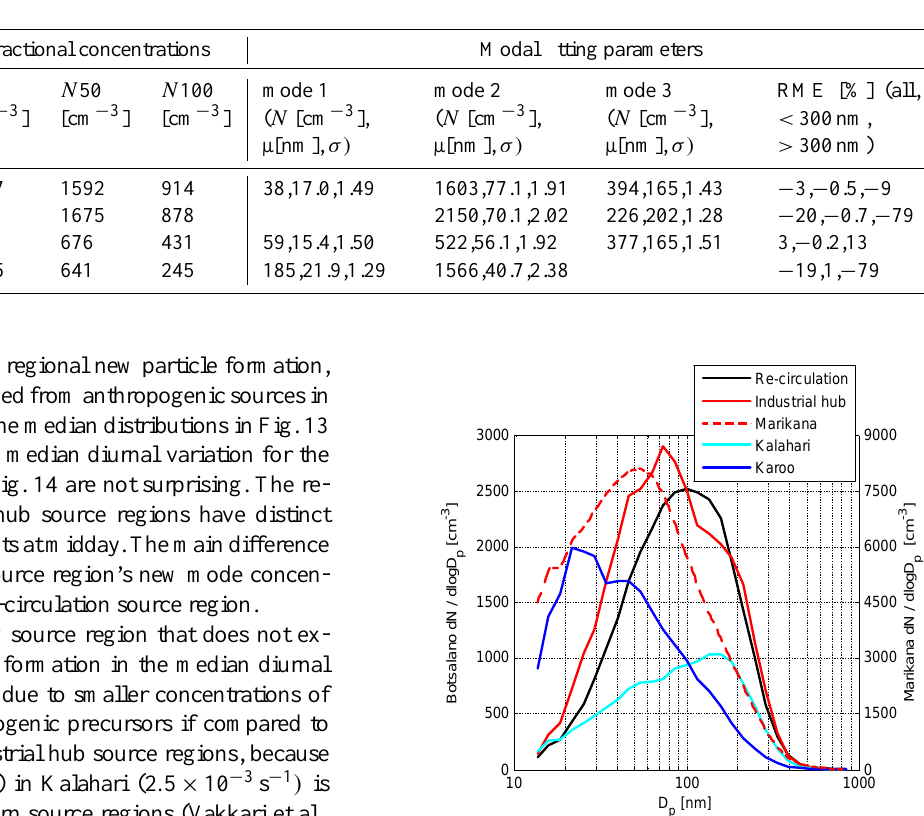
Table 6. Size distribution parameters for the four source regions defined for Botsalano.